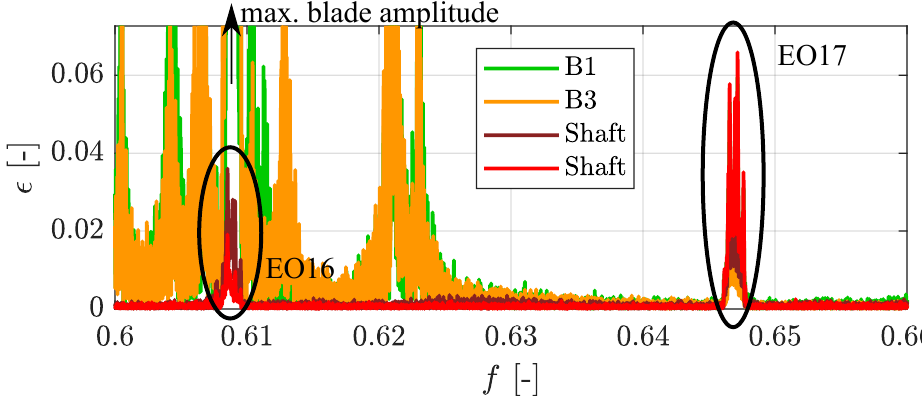
Figure 15. Zoom on EO16 and EO17 excited normalized amplitude of shaft and blade SGs during rotational speed of